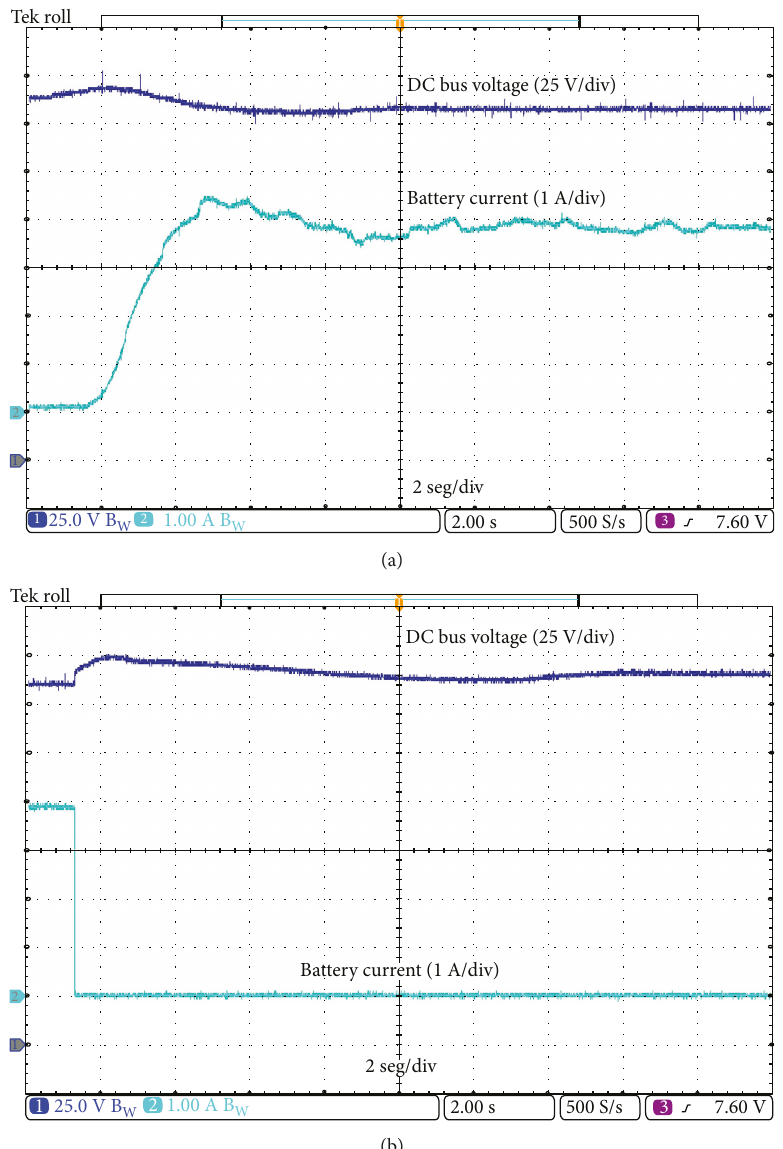
Figure 7: (a) Battery bank charging in process and (b) battery bank charging turned o ff